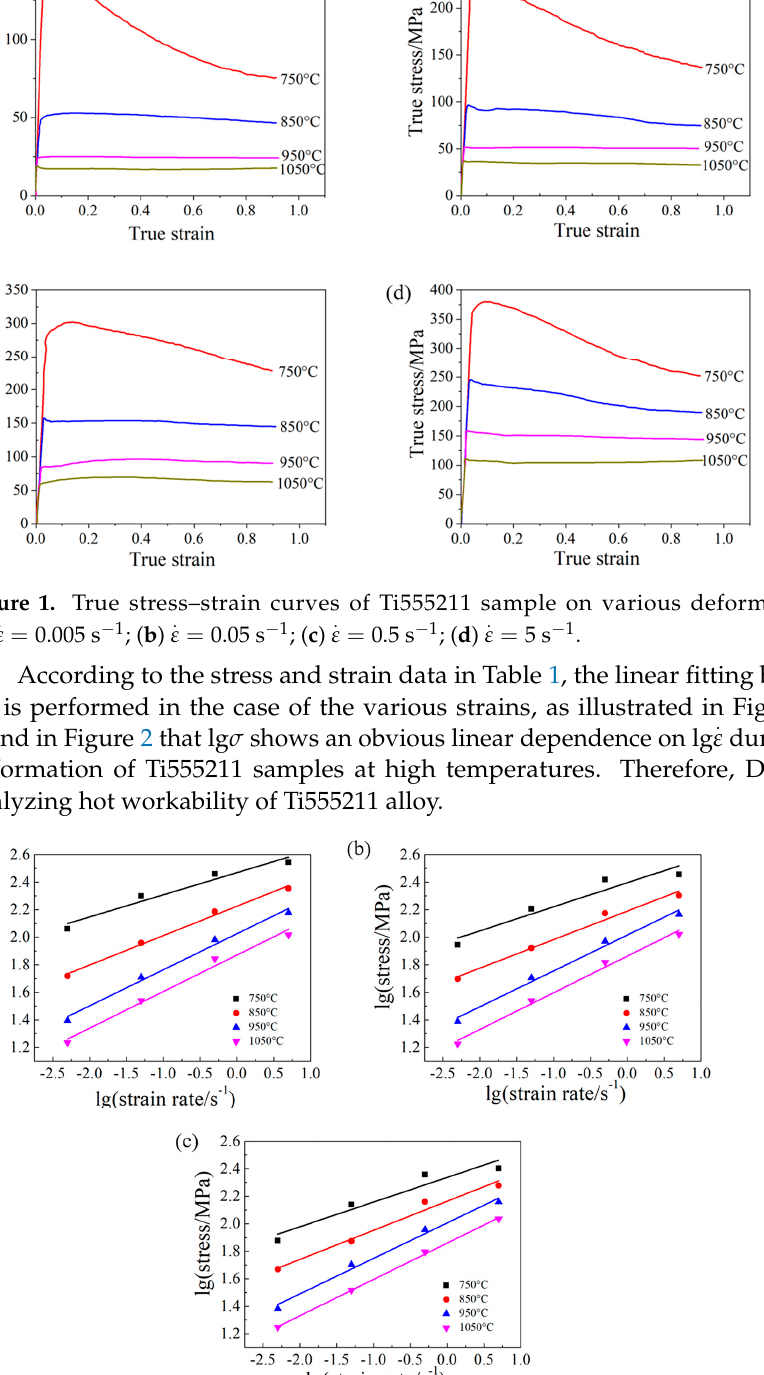
. ε in the case of the various strains for Ti555211